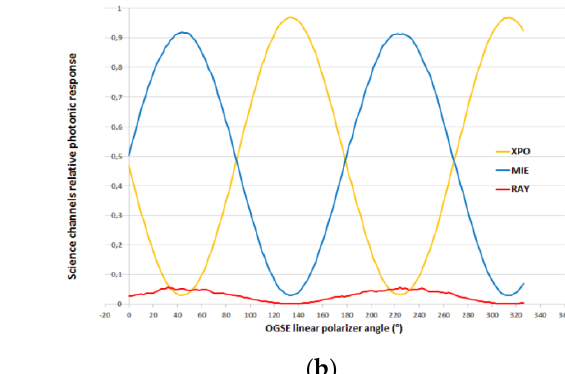
Figure 10. Far field measurement results during simulation of orbital cycles (±1 °C on the laser); the variation of beam divergence (left scale, diameter of 86% encircled energy) plotted over time (overlaid, camera acquired far field images).